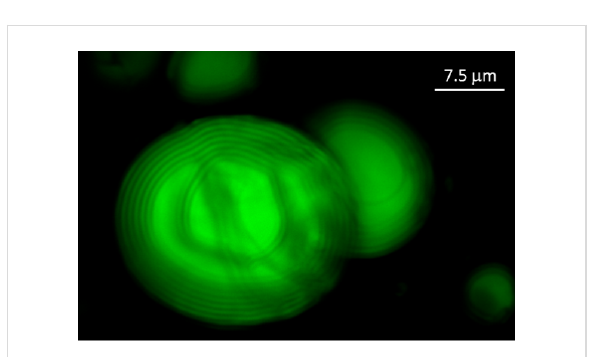
resolution limits of the used confocal microscope. Although the microdroplets are deformed during the drying procedure, their internal periodicity is clearly visible.